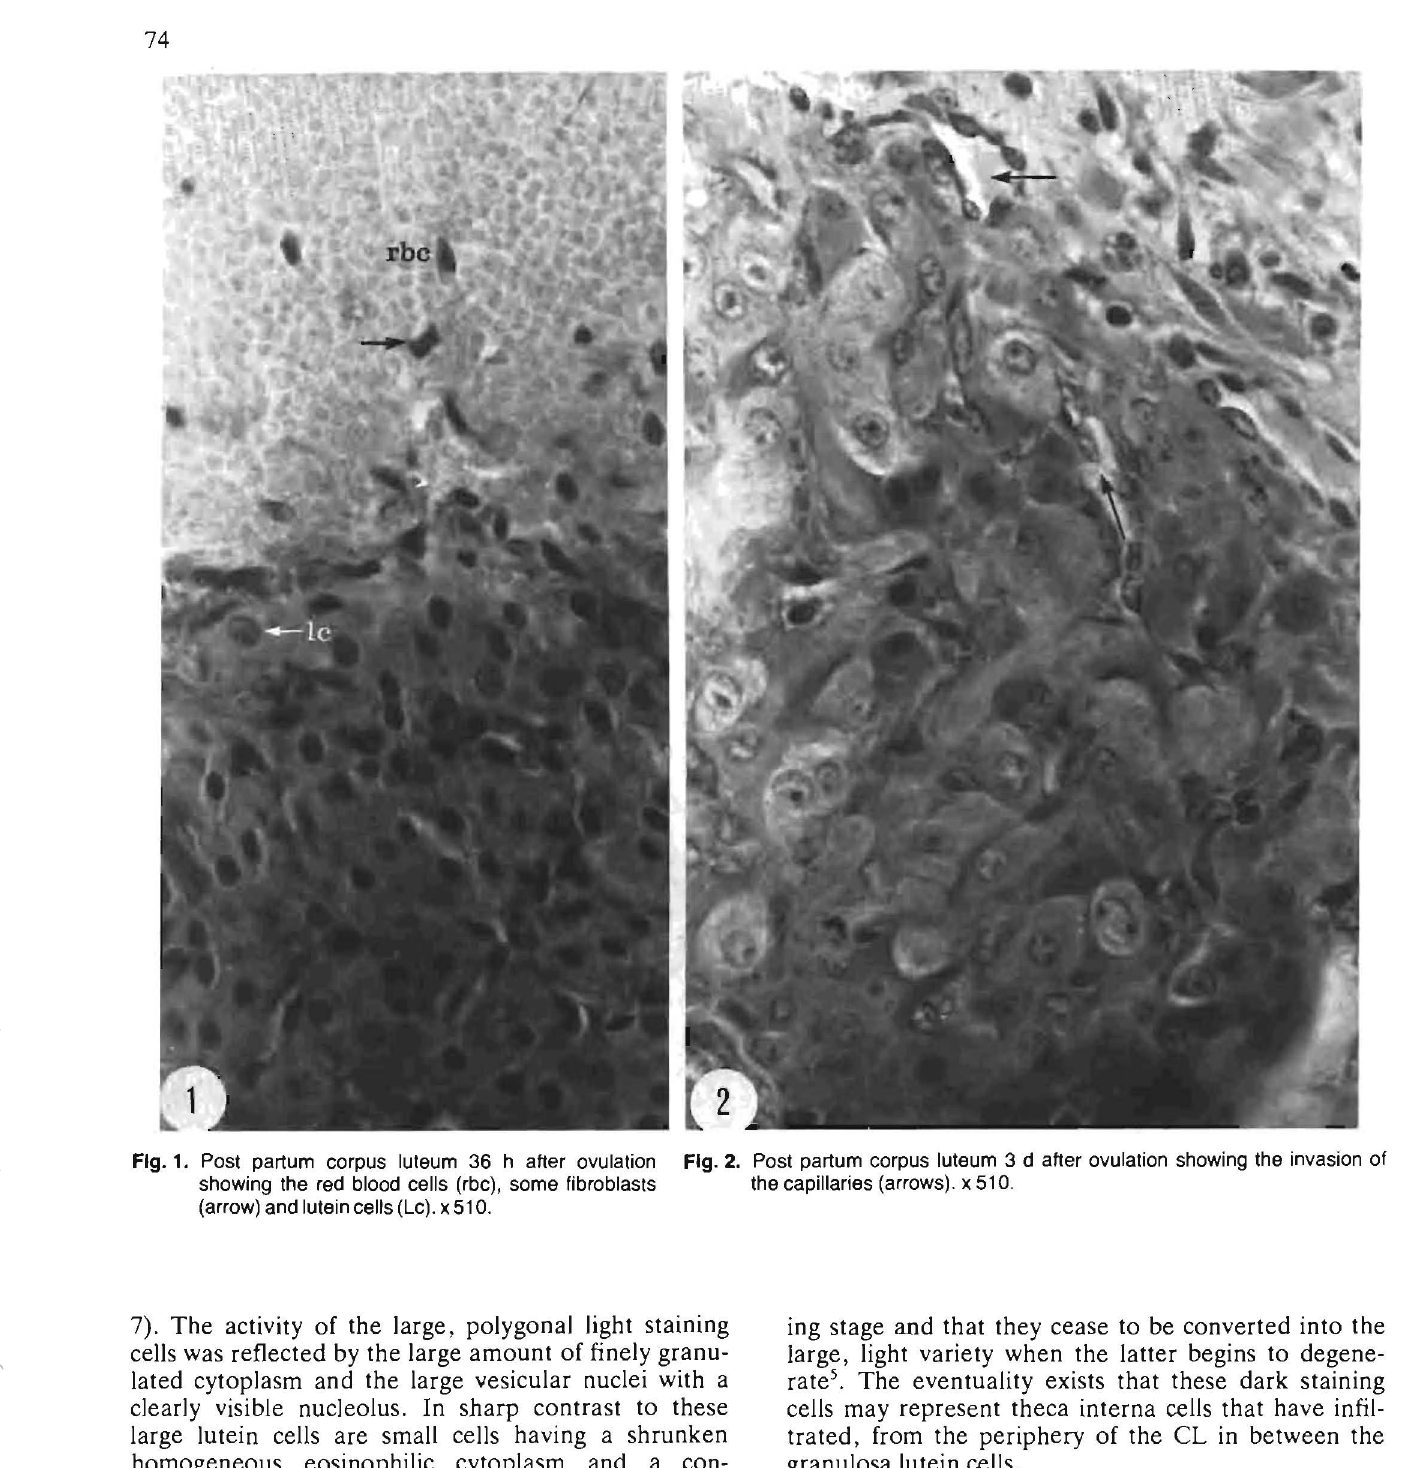
Fig. 2. Post partum corpus luteum 3 d after ovulation showing the invasion of the capillaries (arrows). x